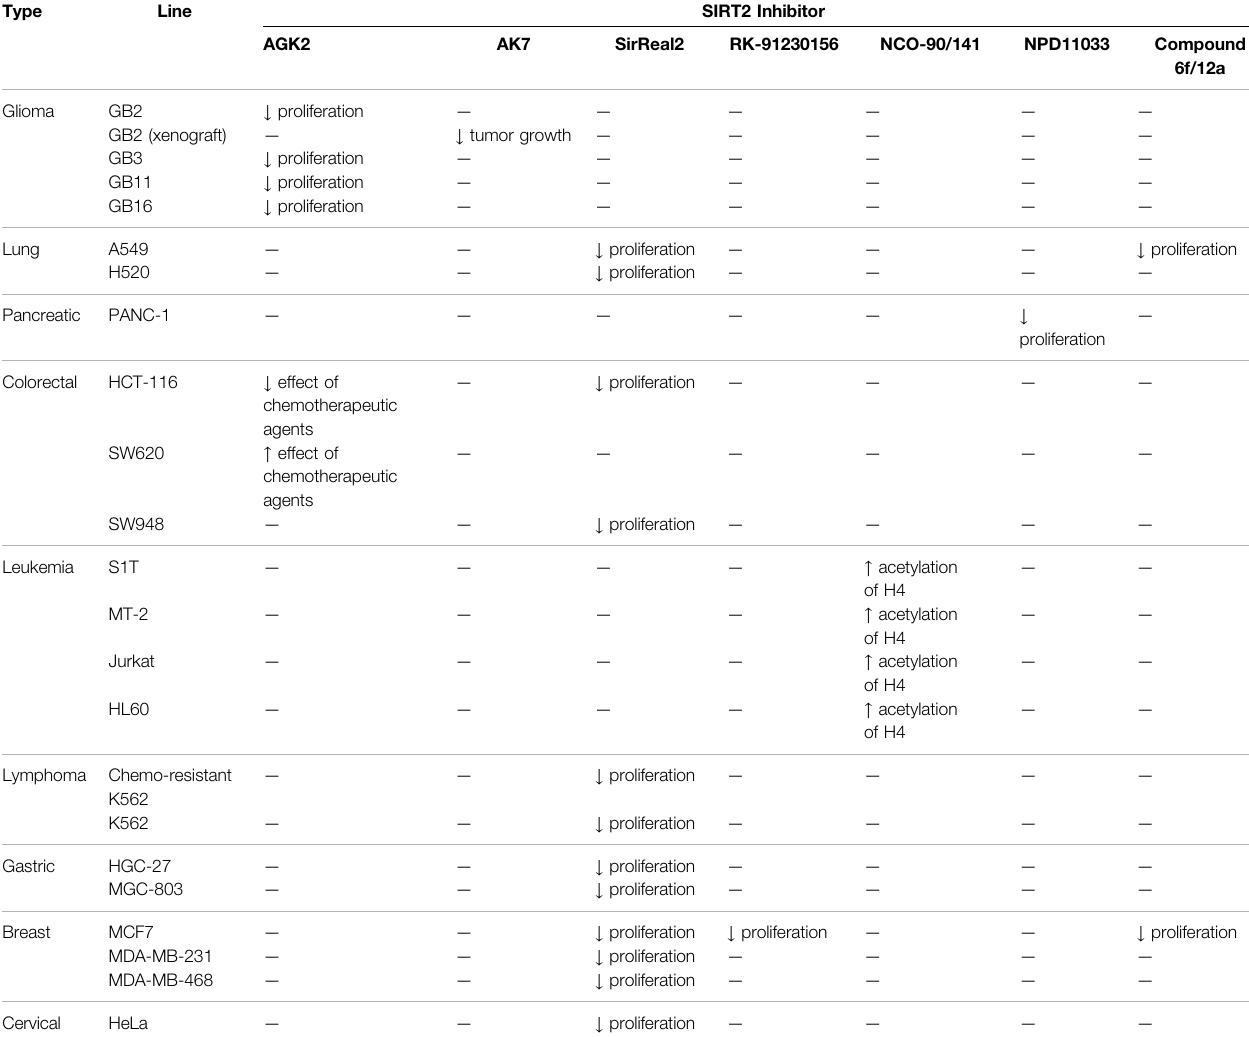
TABLE 3 | Cell lines affected by SIRT2 Inhibitors (#1 set).